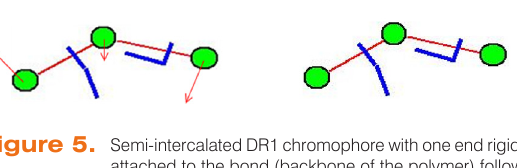
Figure 4. Scheme of chromophore – polymer matrix organization: host guest (doped), full intercalation, semi-intercalation.